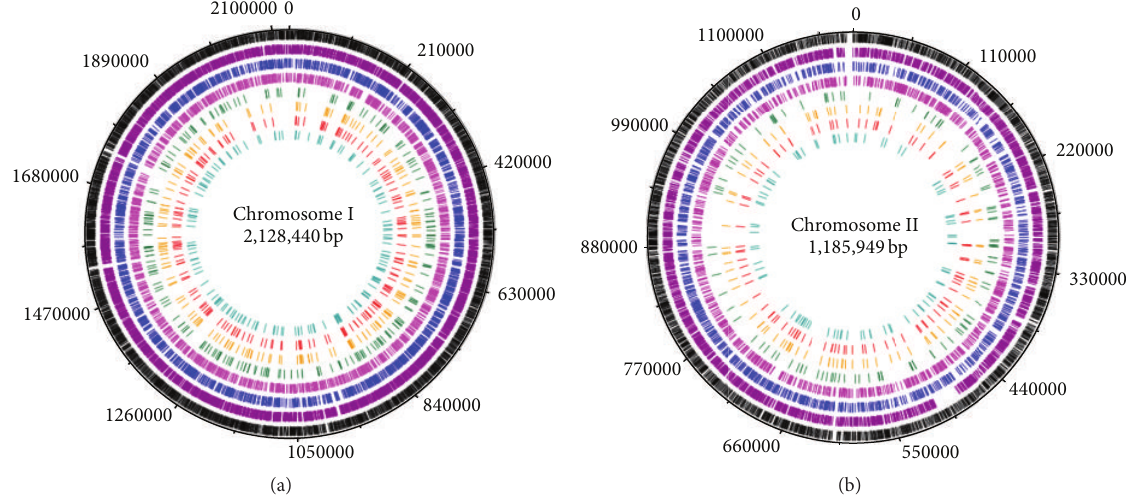
Figure 6: Circular representation of identified Single Nucleotide Polymorphisms in B . melitensis IND1 Chromosome I (a) and Chromosome II (b). Chromosomal coordinates are indicated on outer most circle. From outer to inner, circles represented as circle 1, CDS (black); circle 2, SNPs against B . abortus 2308 (purple); circle 3, SNPs against B . melitensis Ether (blue); circle 4, SNPs against B . melitensis 16M (pink); circle 5, SNPs against B . melitensis NI (green); circle 6, SNPs against B . melitensis M5-90 (Orange); circle 7, SNPs against B . melitensis M 28.